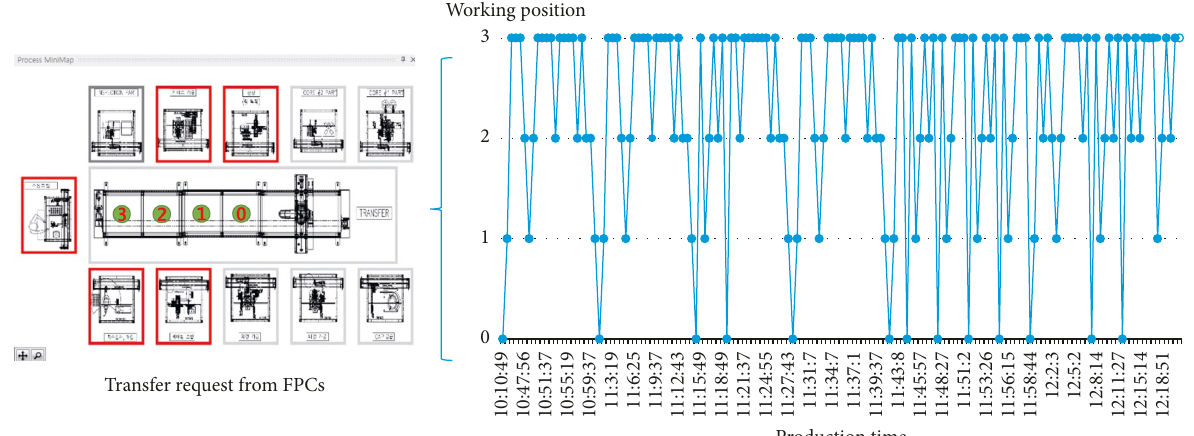
Figure 11: The transfer route of the TR over production time. Table 3: Travelling distance and comprehensive energy consumption of the two strategies. Strategy 1 Travelling distance